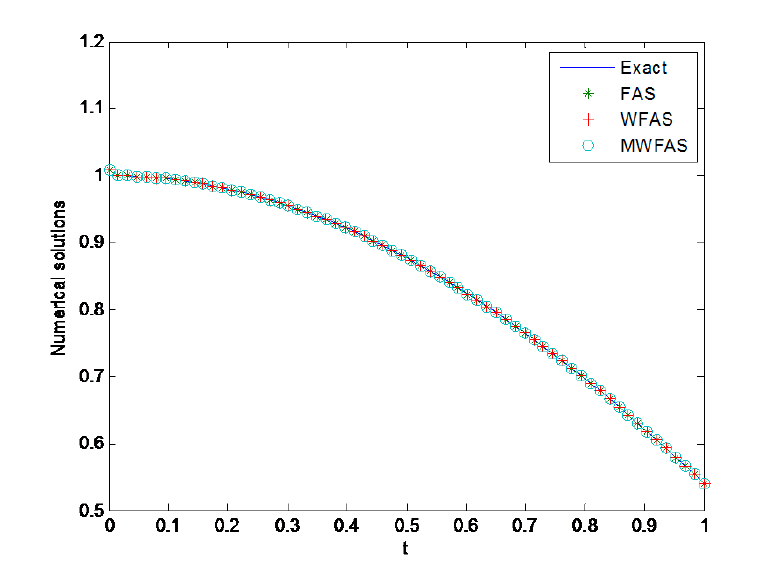
Fig. 3 Comparison of numerical solutions with exact solution of test problem 5.3, for N =64.